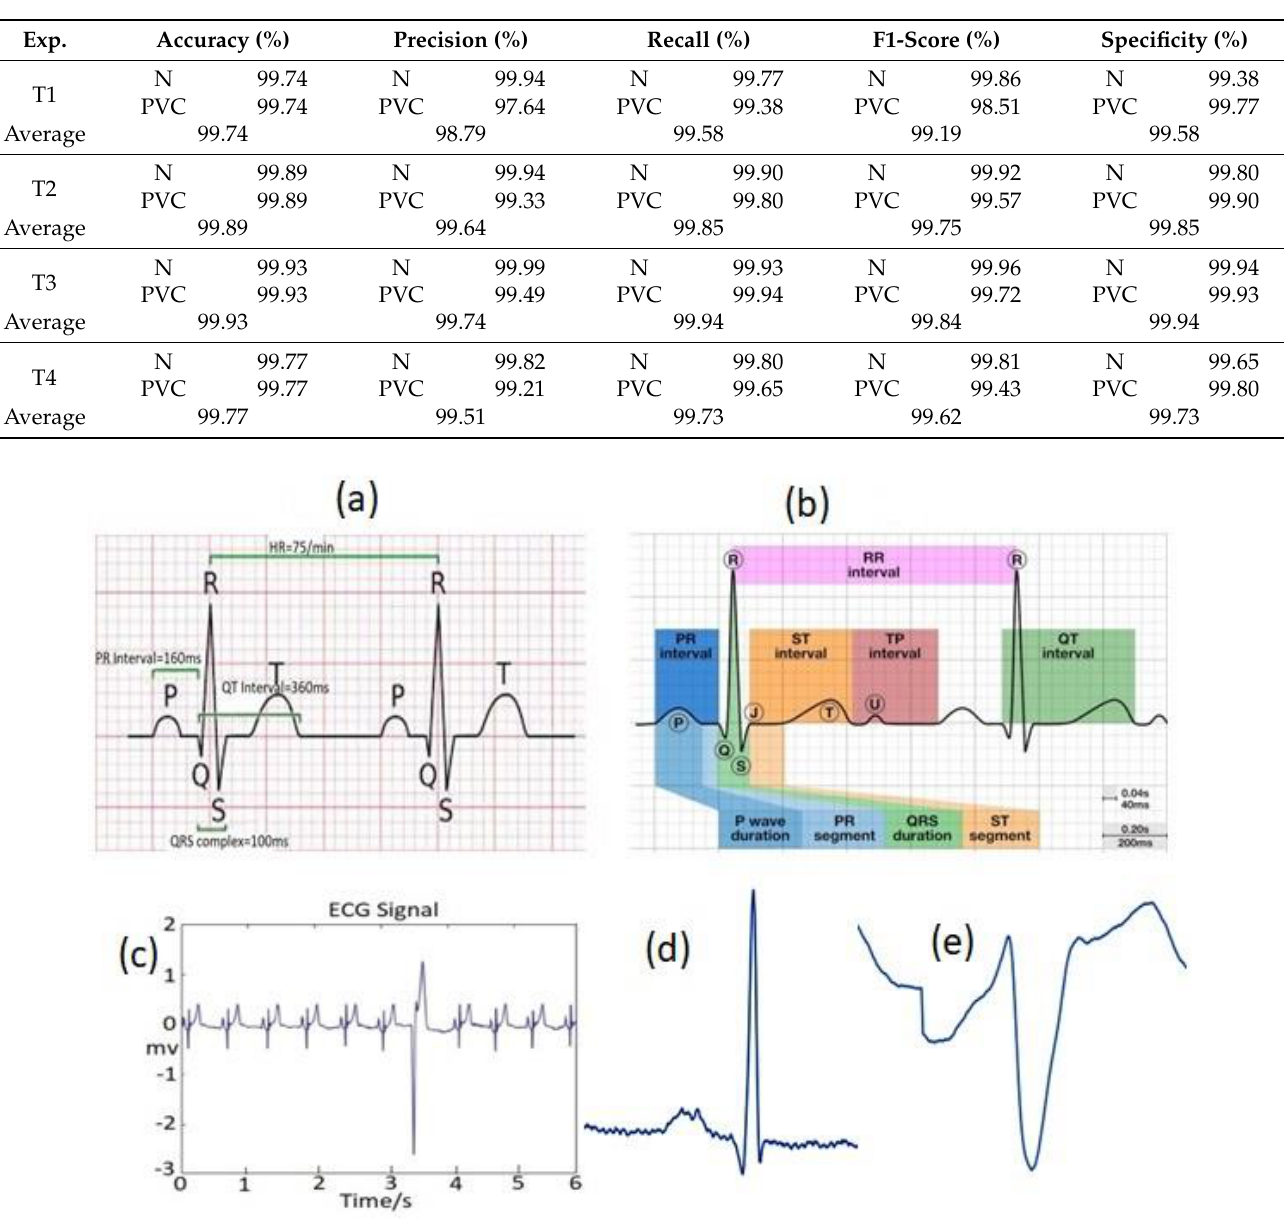
Figure 6. ( a ) A normal ECG signal including a typical P-QRS-T complex and RR-intervals; ( b ) A normal ECG signal with U-wave deflection; ( c ) A sample waveform of a PVC beat and normal beats from the MIT-BIH arrhythmia dataset of a record; ( d ) A sample of the extracted normal image from MIT-BIH; ( e ) A sample of the extracted PVC beat image from MIT-BIH. Table 4. The physiologic features of a normal ECG signal.